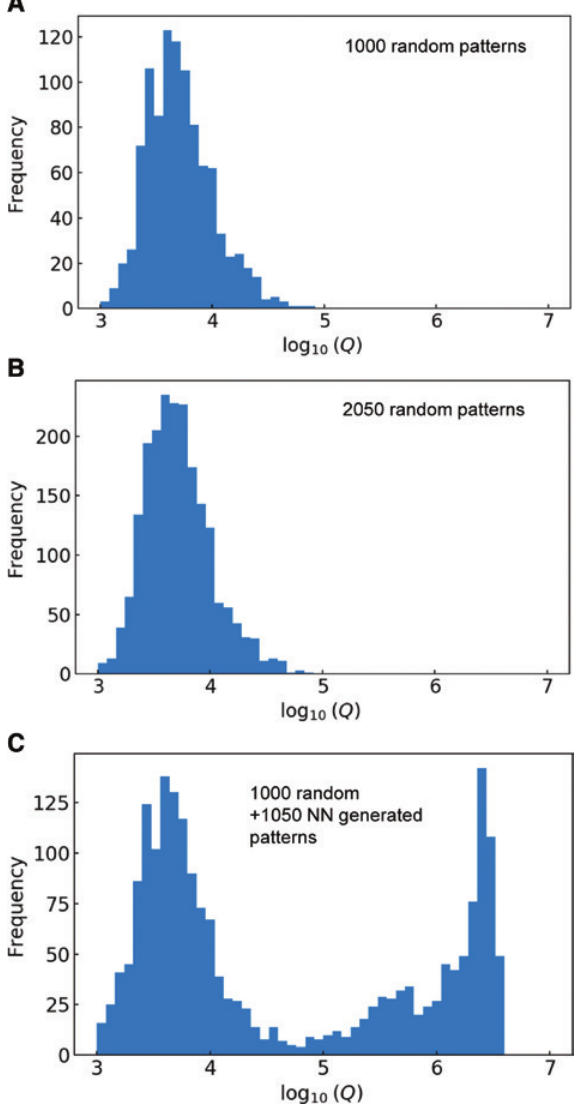
Figure 7: Histrograms of the Q factors in the training datasets generated by different